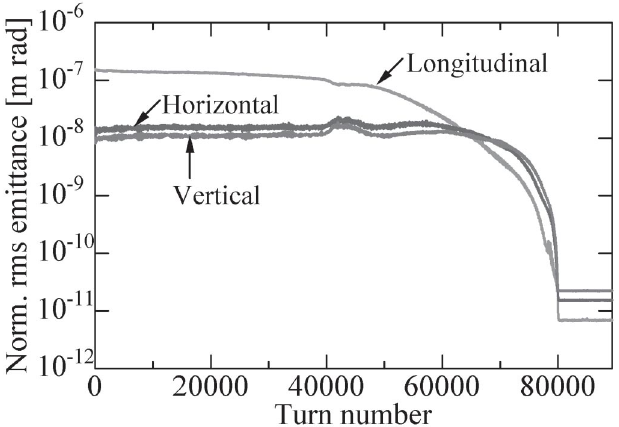
FIG. 10. Time evolution of normalized rms emittances of a 24 Mg (cid:4) beam cooled with two counterpropagating lasers in S- LSR. A regular rf cavity is located in the middle of a straight section where the size of momentum dispersion is 0.8 m. The bare tunes have been adjusted to be (2.067, 1.073, 0.07) for full 3D coupling resonances. A scan of the laser frequency is finished at the 80 000th turn. It is possible to make the scan speed faster, but the efficiency of ion capture becomes worsened at high line density due to intrabeam scattering.